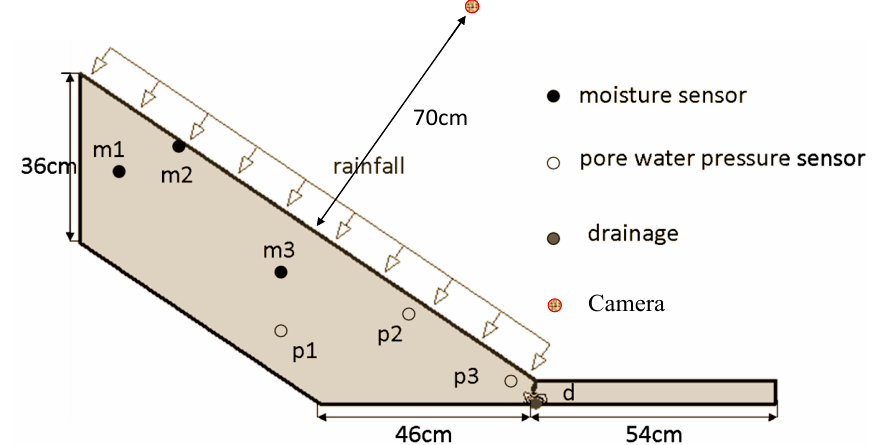
Figure 1. Geometry of physical model.